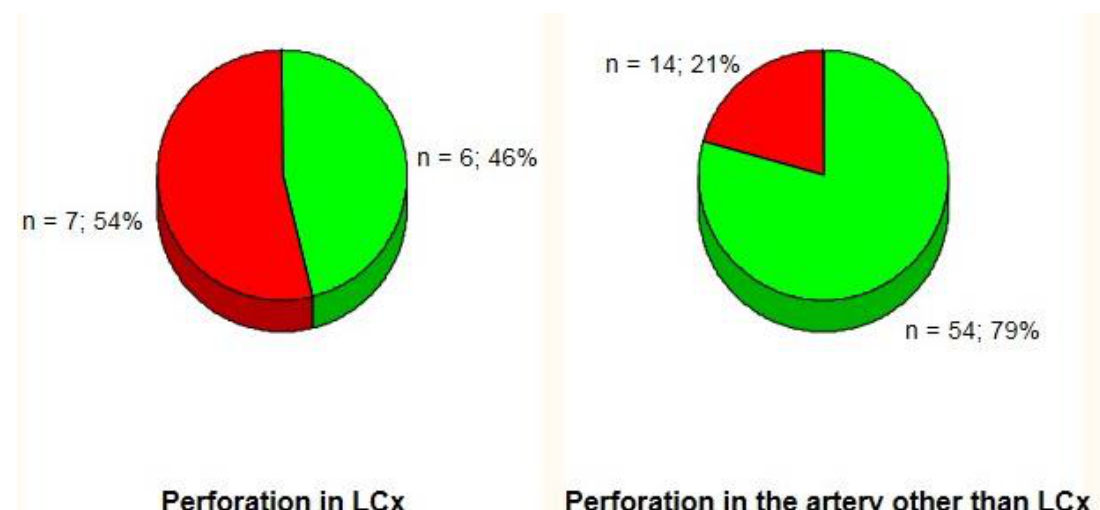
Figure 1. Incidence of acute cardiac tamponade (red area) by perforation site. LCx: left circumflex coronary artery.